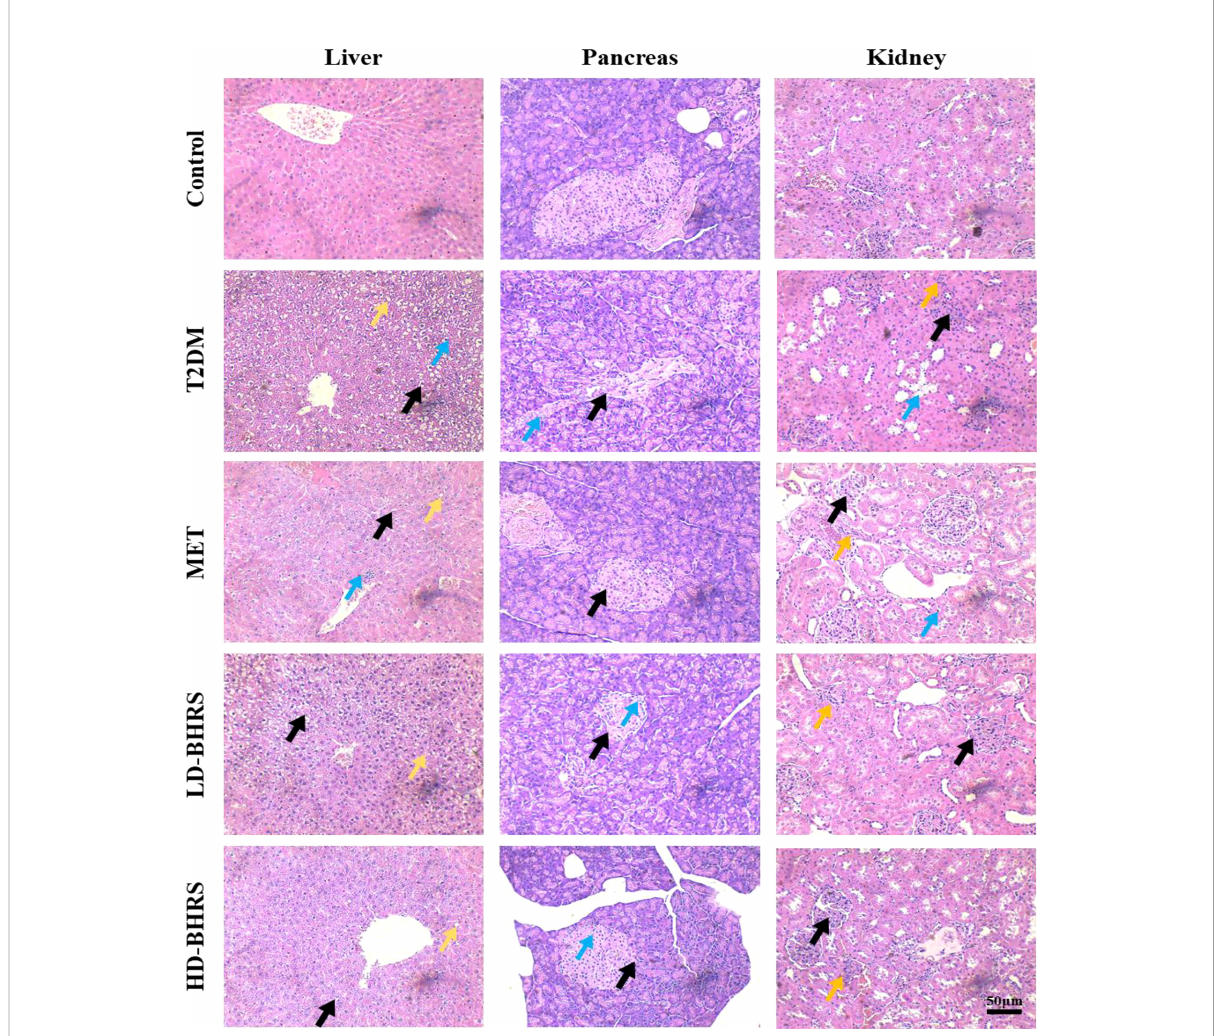
FIGURE 2 HE staining indicated that the pathological changes of liver, pancreas, and kidney were reduced in T2DM model rats after BHRS treatment (Liver: black arrows indicated the cellular swelling of hepatocytes, yellow arrows indicated the steatosis of hepatocytes, and blue arrows indicated the in fi ltration of in fl ammatory cells; Pancreas: black arrows indicated the impaired structure of pancreatic islets, and blue arrows indicated the vacuole-like deformation in endocrine cells; Kidney: black arrows indicated the glomerular hyperplasia, blue arrows indicated the atrophy of the renal tubules, and yellow arrows indicated the in fl ammatory cell in fi ltration)